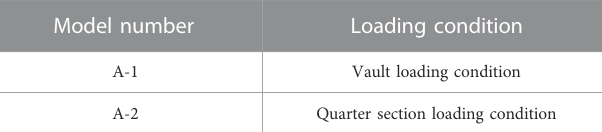
TABLE 4 Description of working